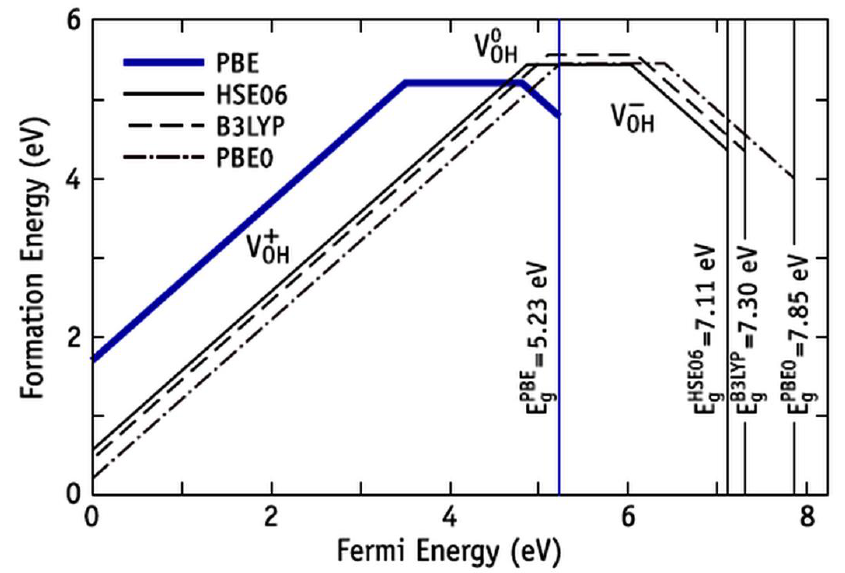
Figure 9. Calculated formation energy of V OH in HAP as a function of the Fermi energy, using different approximations to the DFT exchange–correlation interactions. Positive, neutral, and negative charge states are represented by lines with positive, zero, and negative slope, respectively. For each functional, the Fermi energy can vary between the valence band top (at E F = 0 eV) and the respective conduction band minimum ( E F = E g). (Adapted with permission from ref. [11]; AIP Publishing, 2015). Table 2. Formation energy of hydroxyl group vacancies V 1OH and V 2OH in HAP. (From Kohn-Sham formalism of DFT calculation basically described in work